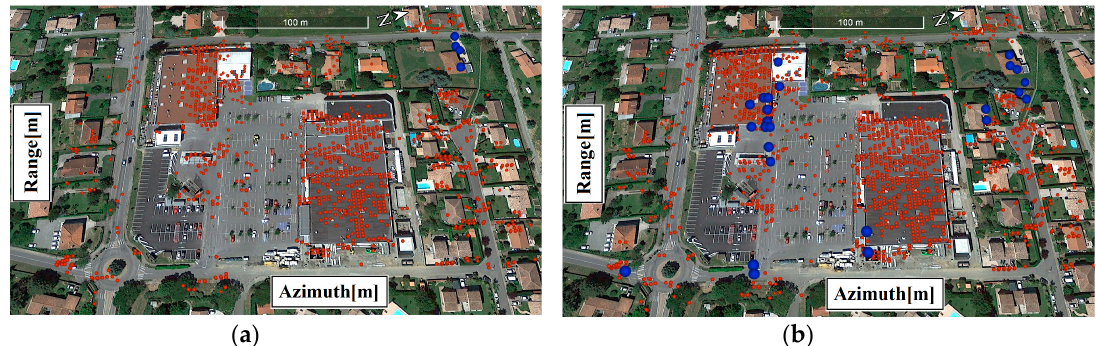
Figure 4. Intensity HH image of the test area near Toulouse, France (copyright DLR 2013–2015).